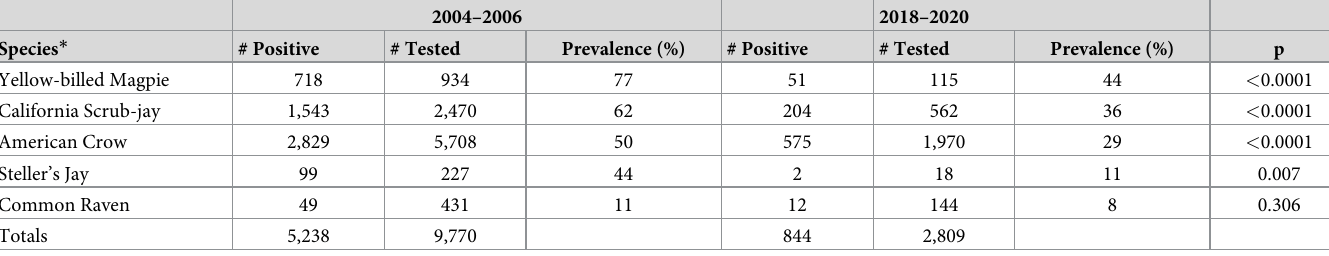
Table 4. West Nile virus infection prevalence in tested dead corvids, early versus recent years.